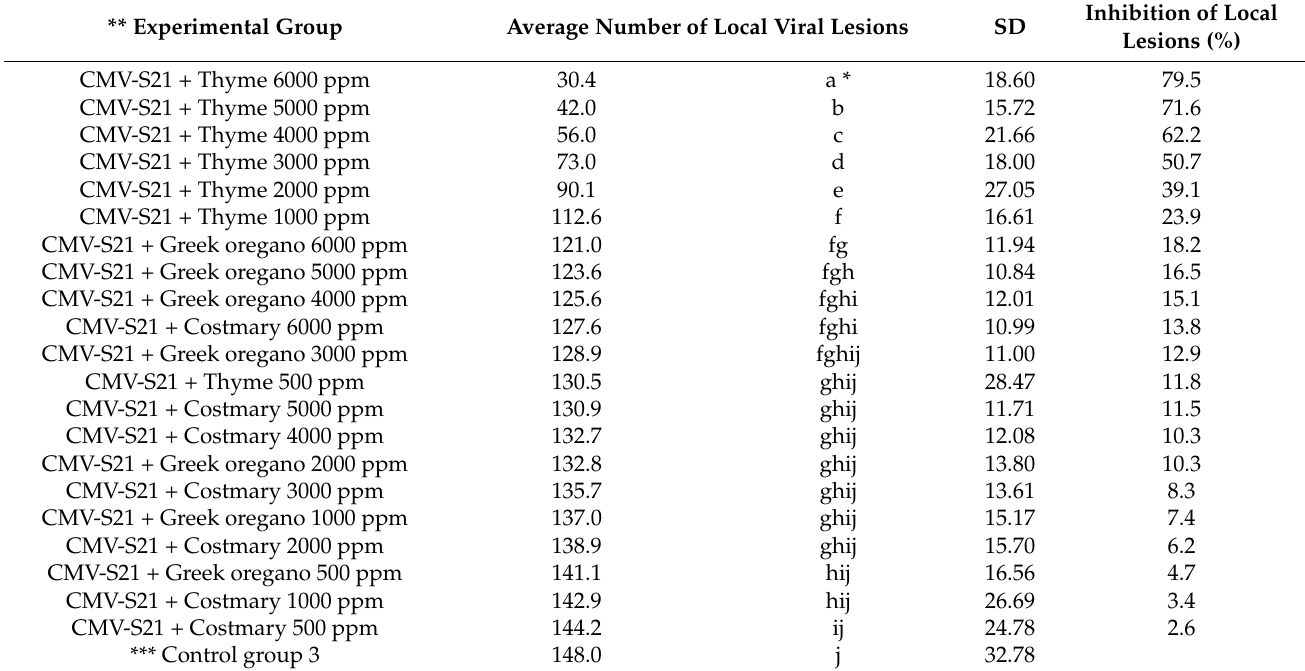
* homogenous group according to the Student–Newman–Keuls test. Values marked with the same letter in a column do not differ statistically at the significance level p = 0.05. ** inoculation with the CMV-S21 isolate +